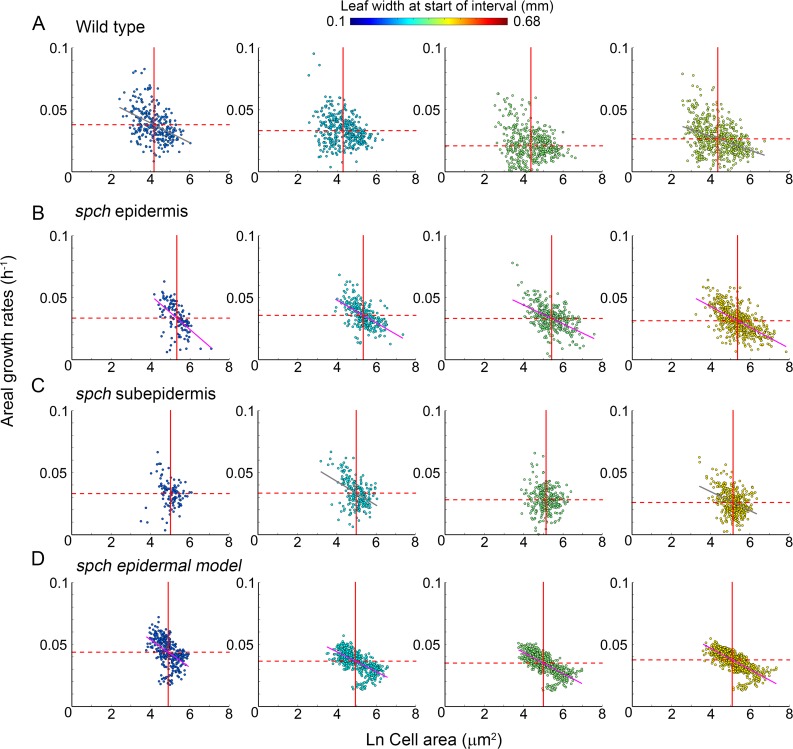
Correlations between growth rates and cell size.Areal cell growth rates against log cell area for time intervals at different developmental stages. Data points are colour coded according to leaf width at the start of the interval (colour scale is shown at the top). Solid red lines indicate mean cell areas (μa) and dashed red lines indicate mean growth rate (μk), with ± ranges indicating 1.96 × standard error of mean. Lines fitted for R2 > 0.2 are shown in magenta; those with R2 < 0.2 and > 0.1 are shown in grey (p-values are all less than 5.1×10−6 for line fits). (A) Wild type (from dataset shown in Fig 7B–7D, time intervals: 12–25 h, 25–37 h, 37–47 h, 47–57 h). From left to right, μa = {4.2 ± 0.08, 4.3 ± 0.07, 4.4 ± 0.07, 4.4 ± 0.07}, μk = {0.038 ± 0.001, 0.033 ± 0.001, 0.021 ± 0.001, 0.026 ± 0.001}, gradient m = {−0.008, −0.004, −0.002, −0.006}, and R2 = {0.18,−,−,0.14}. (B) spch epidermis (from dataset shown in Fig 1, time intervals: 14–24 h, 35–47 h, 47–58 h, 58–74 h), μa = {5.3 ± 0.08, 5.3 ± 0.06, 5.4 ± 0.06, 5.4 ± 0.06}, μk = {0.033 ± 0.001, 0.036 ± 0.001, 0.033 ± 9×10−4, 0.031 ± 8×10−4}, m = {−0.014, −0.009, −0.008, −0.008}, and R2 = {0.31,0.31,0.27,0.38}. (C) spch subepidermis (from dataset shown in Fig 6, time intervals: 14–24 h, 35–47 h, 47–58 h, 58–74 h), μa = {5.0 ± 0.09, 5.0 ± 0.06, 5.1 ± 0.05, 5.1 ± 0.05}, μk = {0.033 ± 0.002, 0.033 ± 0.001, 0.028 ± 0.001, 0.026 ± 9×10−4}, m = {−0.003, −0.010, −0.002, −0.008}, and R2 = {−, 0.19, −, 0.15}. (D) spch epidermal model output at stages corresponding to leaf widths in (B), μa = {4.9 ± 0.05, 4.9 ± 0.05, 5.0 ± 0.04, 5.0 ± 0.04}, μk = {0.045 ± 0.001, 0.037 ± 5×10−4, 0.035 ± 0.004, 0.038 ± 1×10−4}, m = {−0.012, −0.008, −0.008, −0.009}, R2 = {0.33,0.42,0.54,0.59}. Source data are available from https://figshare.com/s/b14c8e6cb1fc5135dd87. Ln, natural logarithm; spch, speechless.